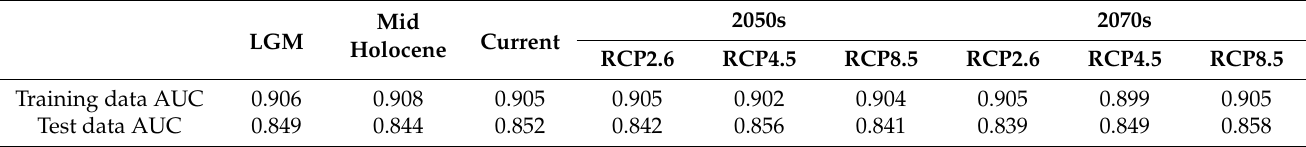
Table 2. Prediction validation with ROC in